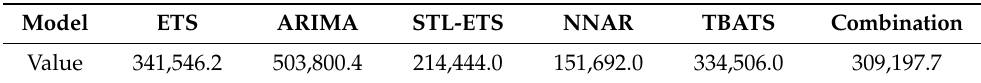
Figure 12. Annual forecast of malaria cases to the end of 2036. Note: Malaria cases are obtained by multiplying the absolute number on the y-axis by 10³. Here, the best method is the seasonal naive method (regardless of the accuracy meas- ure used). Table 3. Predictive models for malaria episodes over the next 16